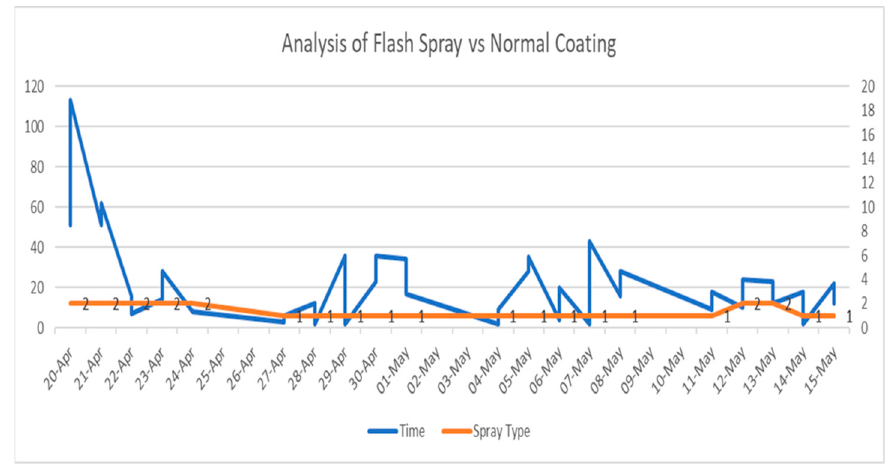
Figure 14. Analysis downtime due to tablet feed issues of Flash Spray (a 22-min spray) vs. Full Spray (a 72 min spray) showed no difference in downtime because of the two spray types over the 4 weeks of the analysis. Flash Spray type 2 used from 21 April to 27 April and 13 May to 16 May and Normal Spray Type 1 utilized from 28 April to 12 May.